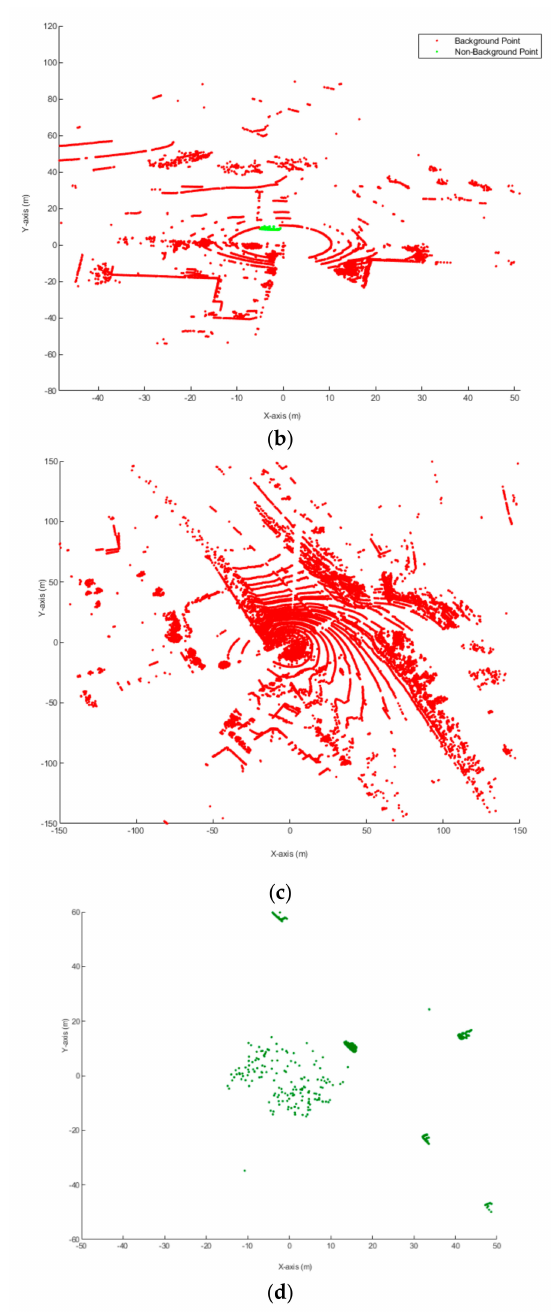
Figure 6. GS-DSF under rainy and snowy weather: ( a ) Rainy weather: Before GS-DSF, ( b ) Rainy weather: After GS-DSF, ( c ) Snowy weather: Before GS-DSF, ( d ) Snowy weather: After